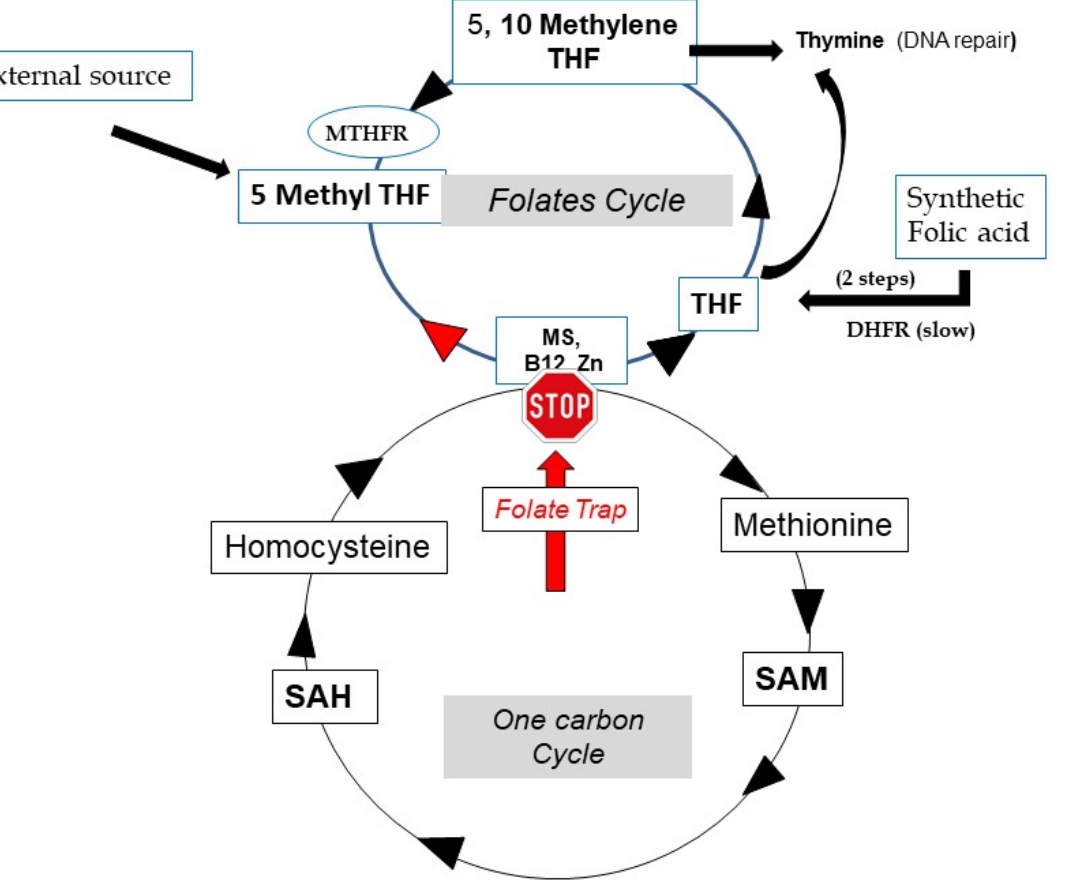
Figure 3. The folate trap: shortage of B12 blocks Methionine synthase activity. Hcy increases, the folate cycle is partly inverted and THF is not re-formed.